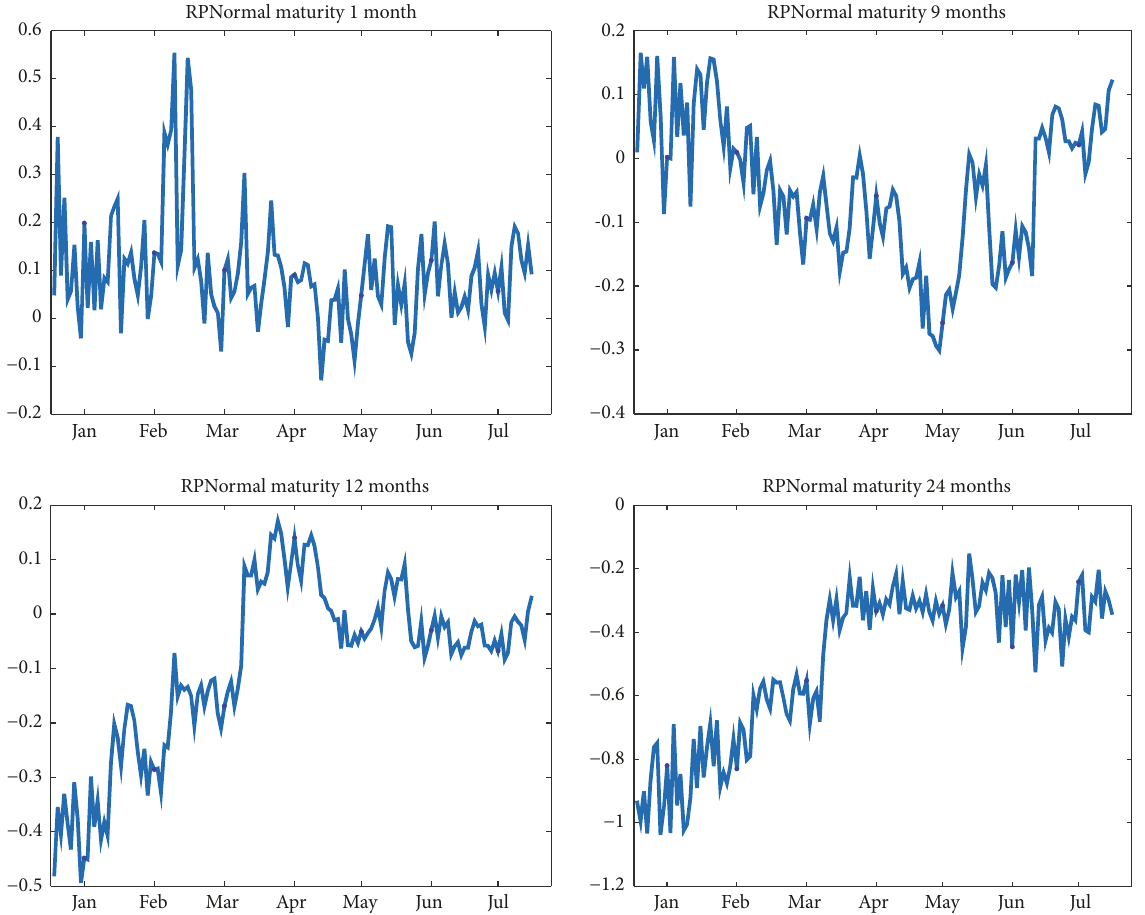
Figure 4: The risk premium for the JDMN model along the out-of-sample, for maturities 1, 9, 12, and 24